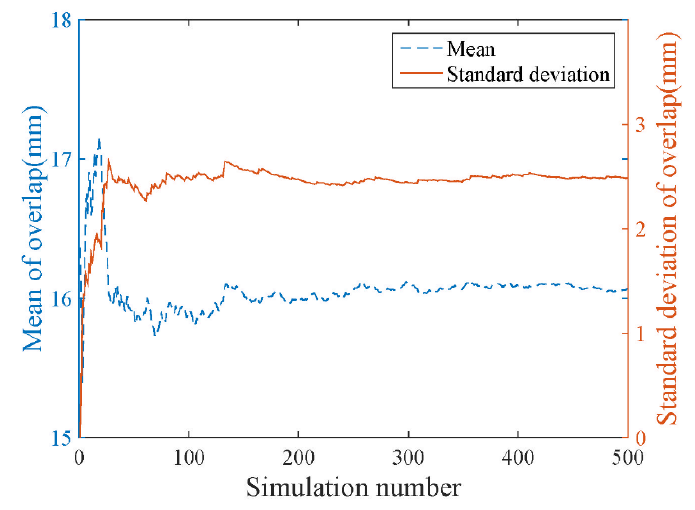
Figure 6. Validation of mean and standard deviation. Table 3. Reference case and parametric study.